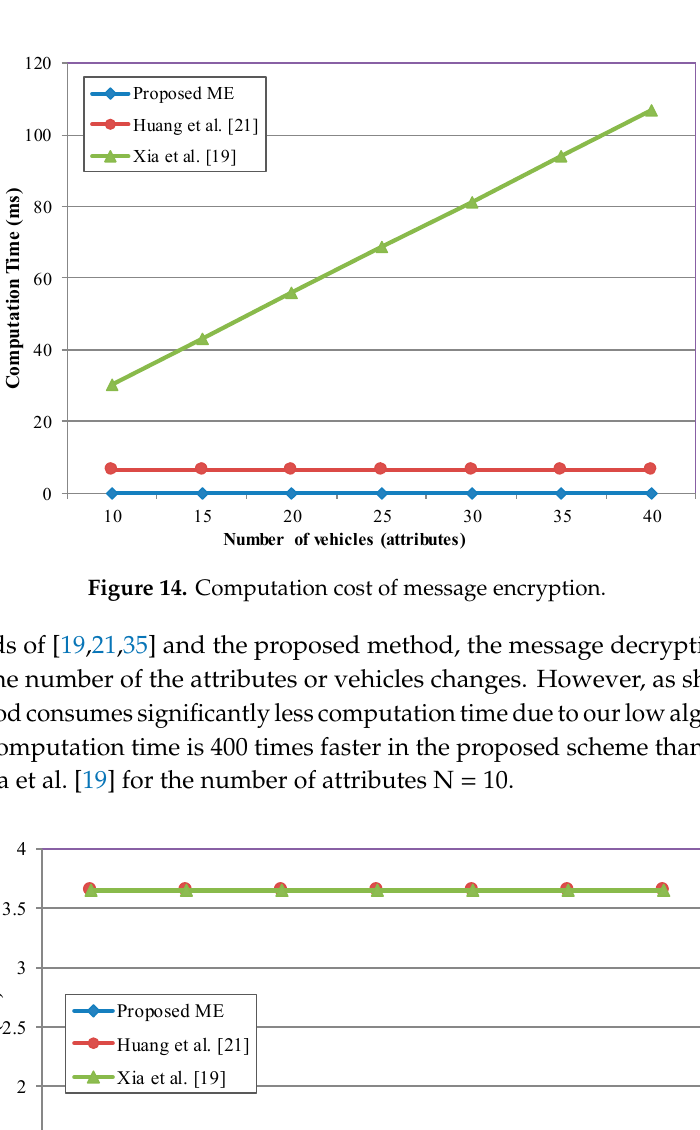
Figure 14. Computation cost of message encryption.